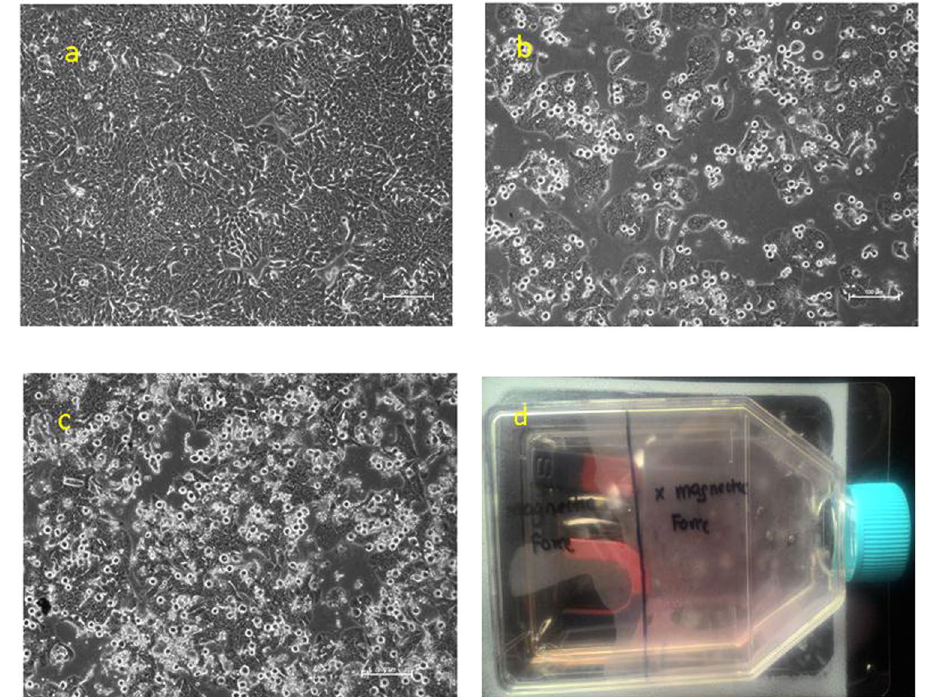
Figure 14. Microscopy of HT29 cells treated with CPT-CEF with magnets. Cells were exposed to the IC 50 concentration of CPT-CEF and viewed at 48 h. Panel a (untreated HT29 cells at 48 h), ( b ) (IC 50 treated HT29 cells for 48 h with magnets), ( c ) (IC 50 treated HT29 cells for 48 h without magnets), ( d ) (Treated HT29-T75 flask with magnets placed under one side of the flask and another side of the flask without magnets). Under phase contrast microscopy, cells treated under magnetic environment shows significant changes in cell to cell attachment in comparison to treated cells without the influence of magnets. Microscope magnification × 100 and scale bar of 100 µ m were applied for all the